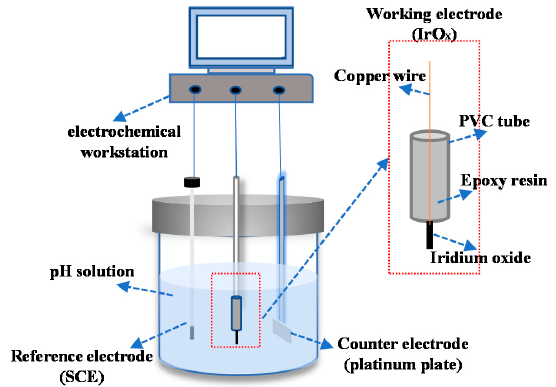
Figure 1. Schematic picture of the pH testing setup.